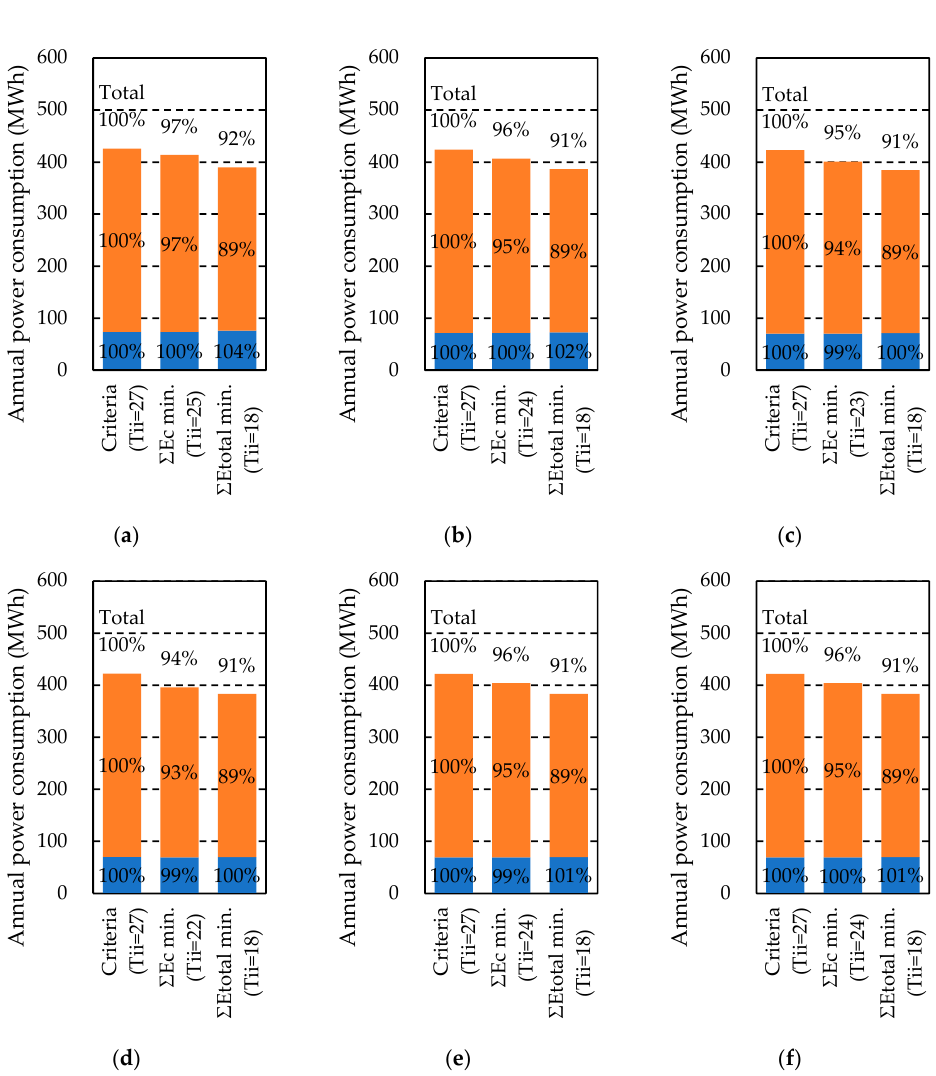
According to Equation (11), as Tii rises, the ITE annual power consumption ( Σ E i ) increases, so pPUE decreases. The original desirable state is to minimize the annual total power consumption